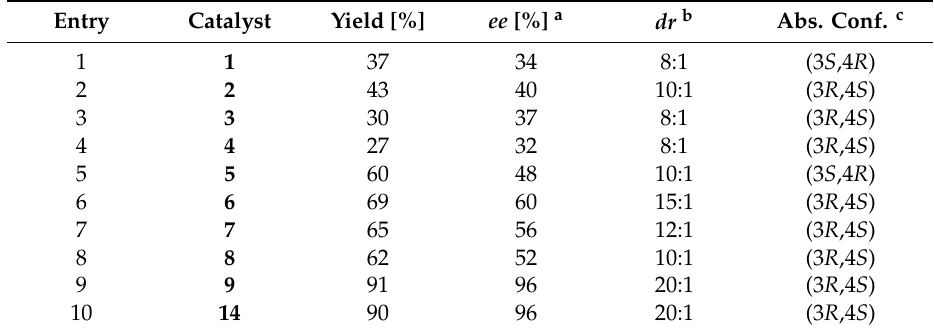
Table 1. Three-component asymmetric Mannich reaction in the presence of aziridines 1 – 9 , 14 .